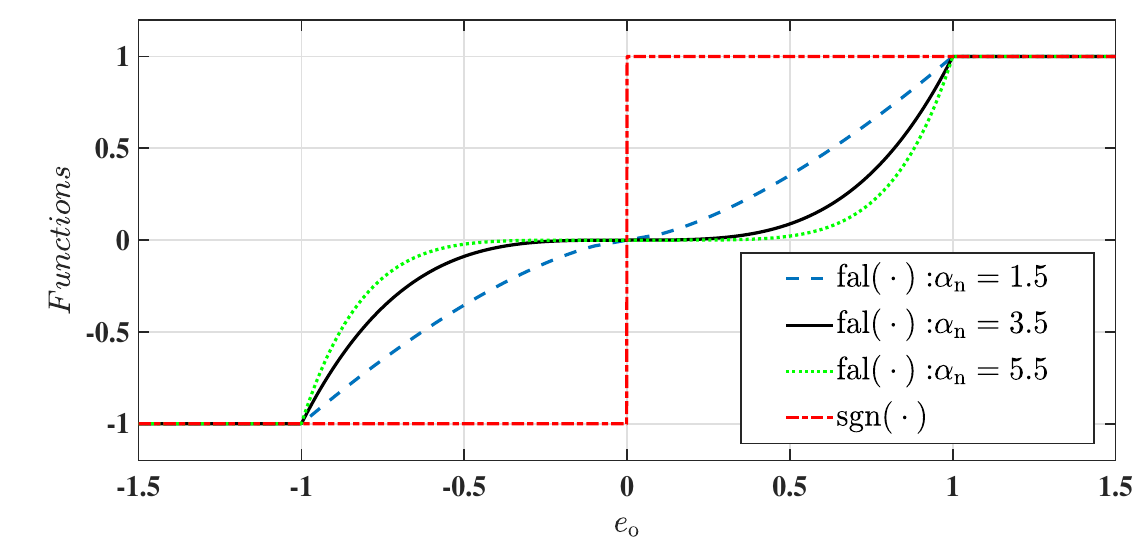
Figure 5. The characteristic curves of fal ( · ) and sgn ( · ) .